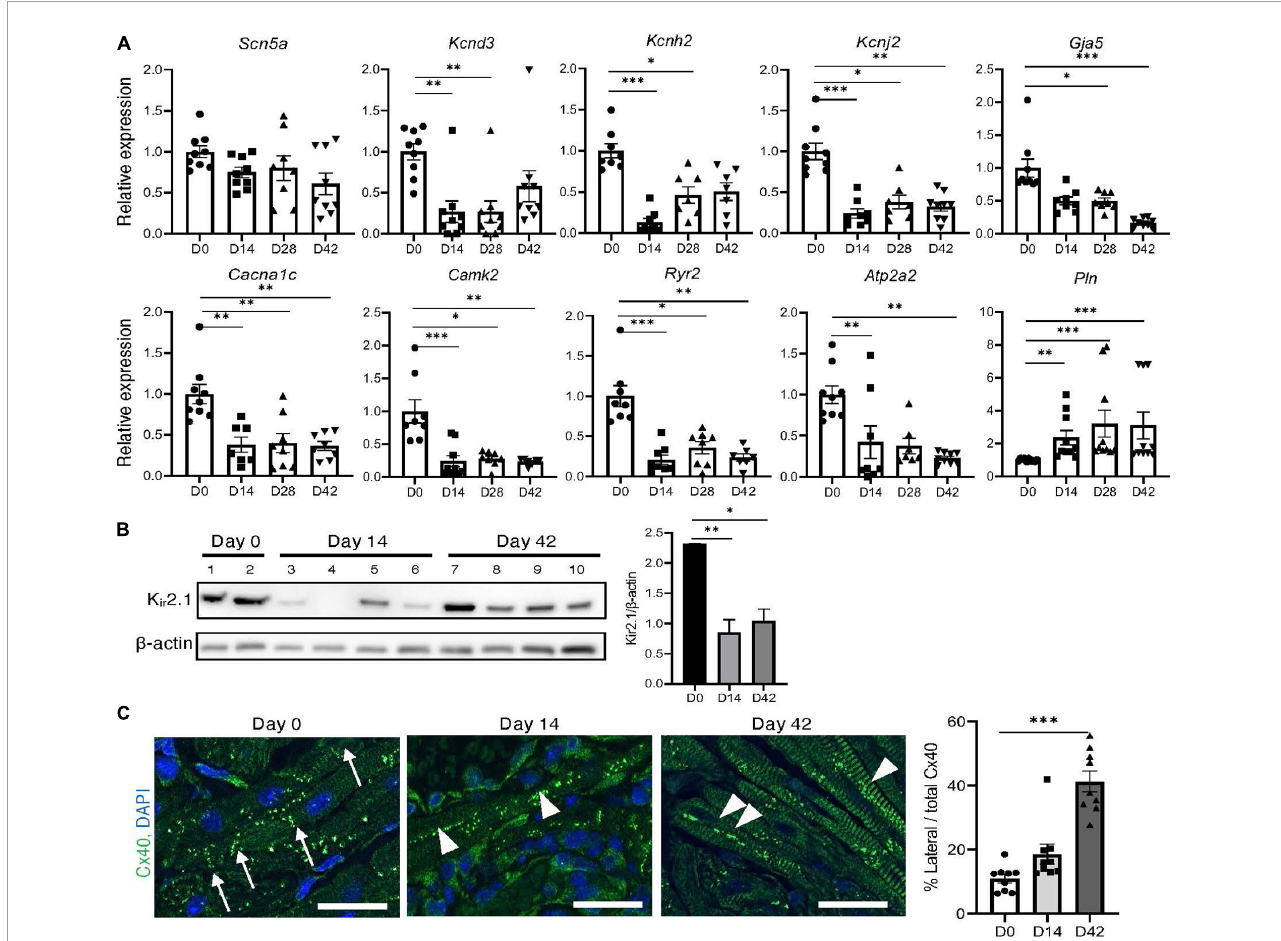
FIGURE3 Electrical remodeling in inflammatory atrial cardiomyopathy. (A) Expression of electrical remodeling-related genes in the atria. (B) Western blot analysis of the atrium. The bar graph shows the ratio of Kir2.1 to β -actin. (C) Immunohistochemical analysis of Cx40 in the atrium. The arrows indicate organized Cx40 complexes at the junctional plaques between two adjacent cardiomyocytes. The arrowheads indicate Cx40 lateralization. Scale bars = 50 µ m. The bar graph shows the Cx40 lateralization quantitative analysis results. ∗ P < 0.05, ∗∗ P < 0.01, ∗∗∗ P < 0.001 using the Kruskal–Wallis test with Dunn’s test. Cx40, anti-connexin